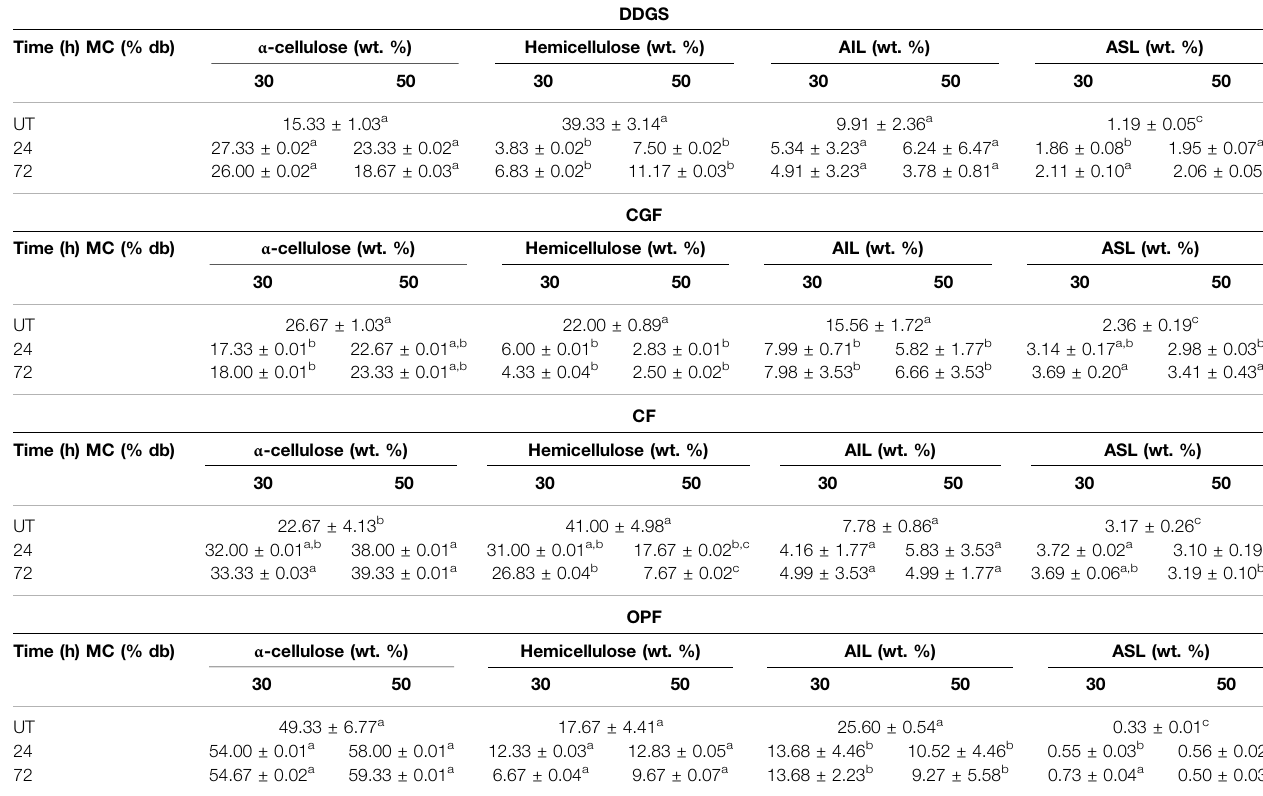
TABLE 4 | Interaction effects of factors on biomass compositions after LMAA